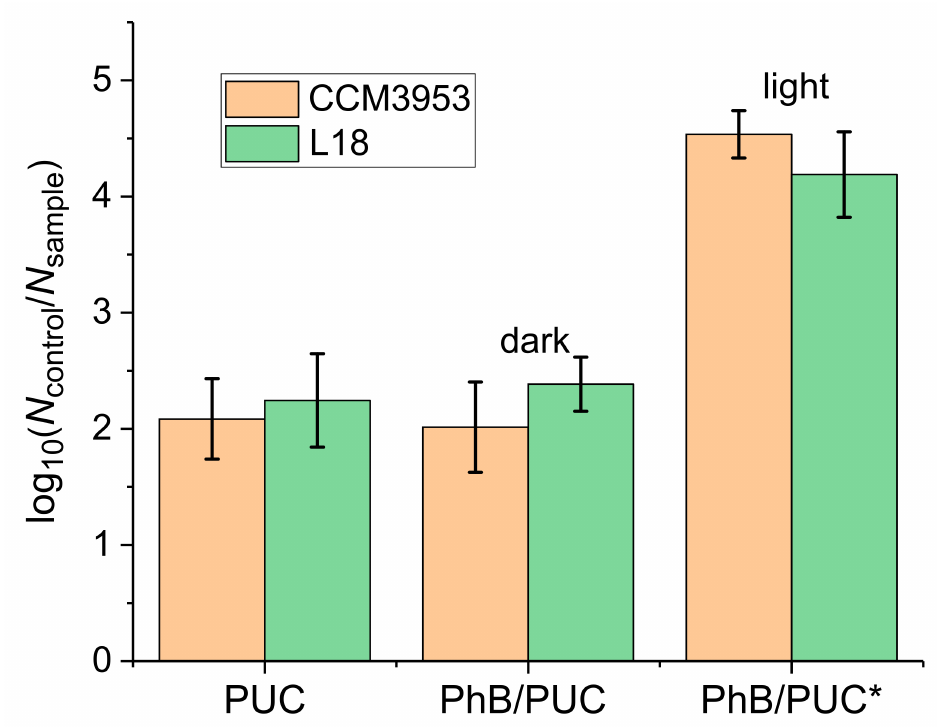
Figure 8. Anti-biofilm effectivity of polyurethane composite (PUC) membranes expressed as the decadic logarithm of cell reduction. The cell number reduction is expressed by the function log( N control / N sample ), whereby N control represents the number of biofilm cells per 1 mL grown in the control group (non-modified PU membrane) (~10 9 ); N sample represents the number of biofilm cells per 1 mL grown on modified PU membranes (PUC, PhB/PUC); * denotes the sample irradiated with a